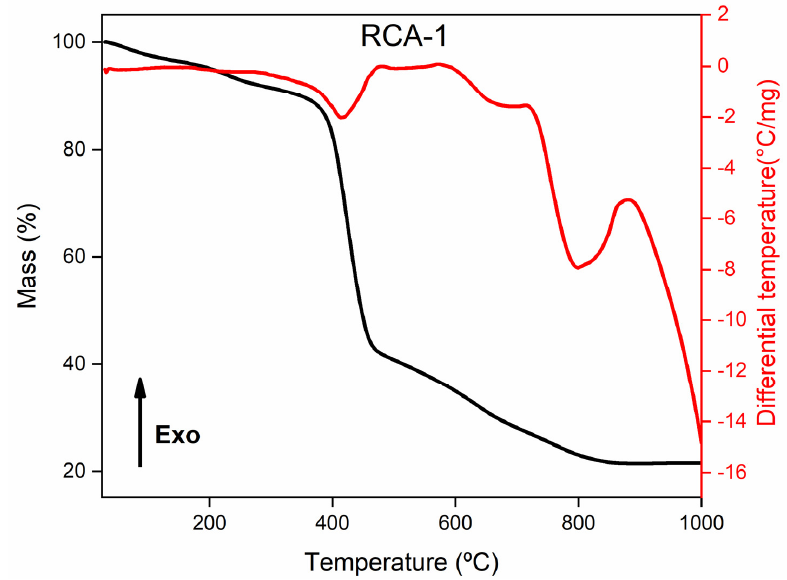
Figure 4. TGA − DSC curves obtained for the compound after the activation process (RCA − 1 sample).